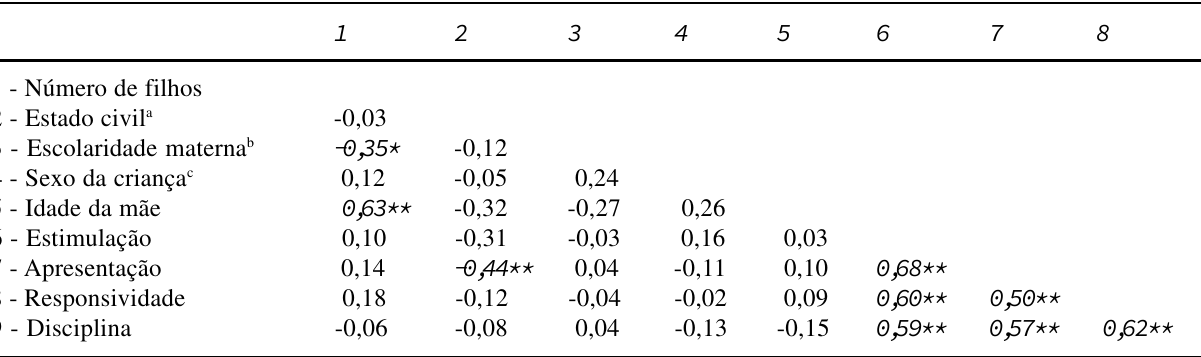
Estimulação foram entre as mães da ZR e ZUES, e tam-